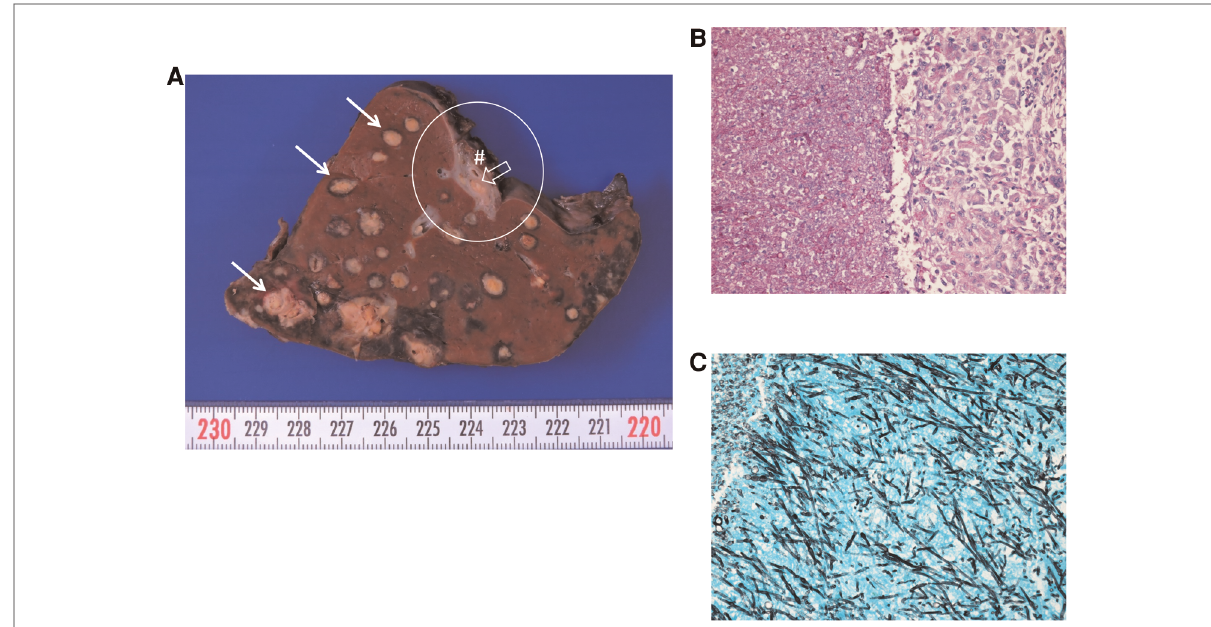
FIGURE 2 Macroscopic and microscopic image of the ruptured spleen. ( A ) Macroscopic image of the spleen. Solid arrows indicate multiple intravascular fungal lesions with perifocal bleeding. Asterisk shows the red pulp with dark brown discoloration consistent with transfusion associated hemosiderosis. Circle shows the splenic hilum with the lienal vein (hash sign), where fungal lesions outside the spleen can be identi fi ed (open arrow). ( B,C ) Microscopic images of a splenic lesion following periodic acid – Schiff (PAS). ( B ) and Grocott ’ s silver staining ( C ) showing hyphae and chlamydoconidiae of Fusarium solani . The length of the lower border is 612 µm each.